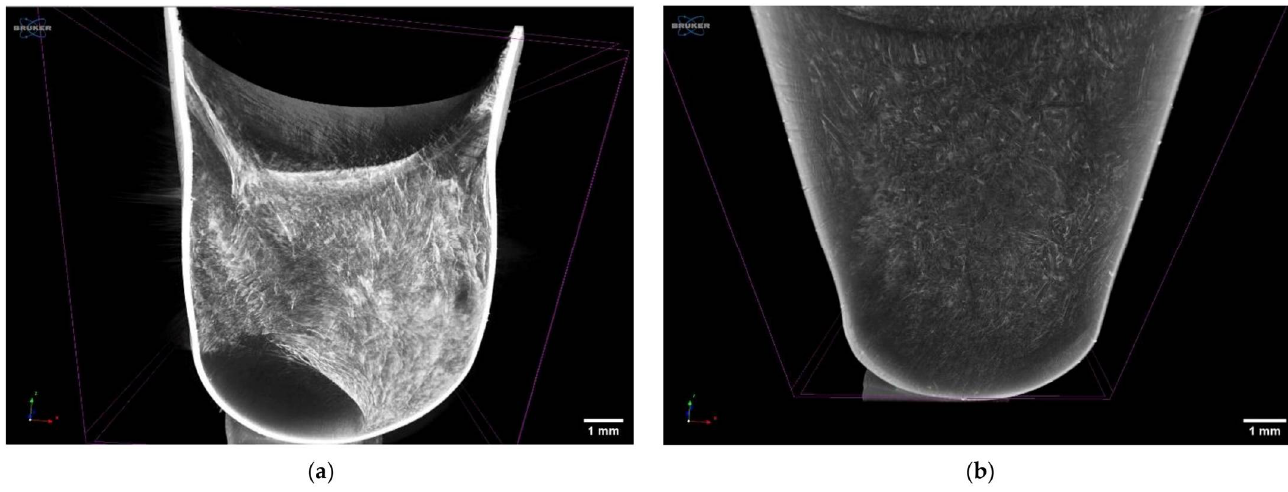
Figure 10. The microCT images of capsules filled with curcumin– β CPCD complex ( a ) and curcumin– β CDP complex ( b ) after lyophilization .